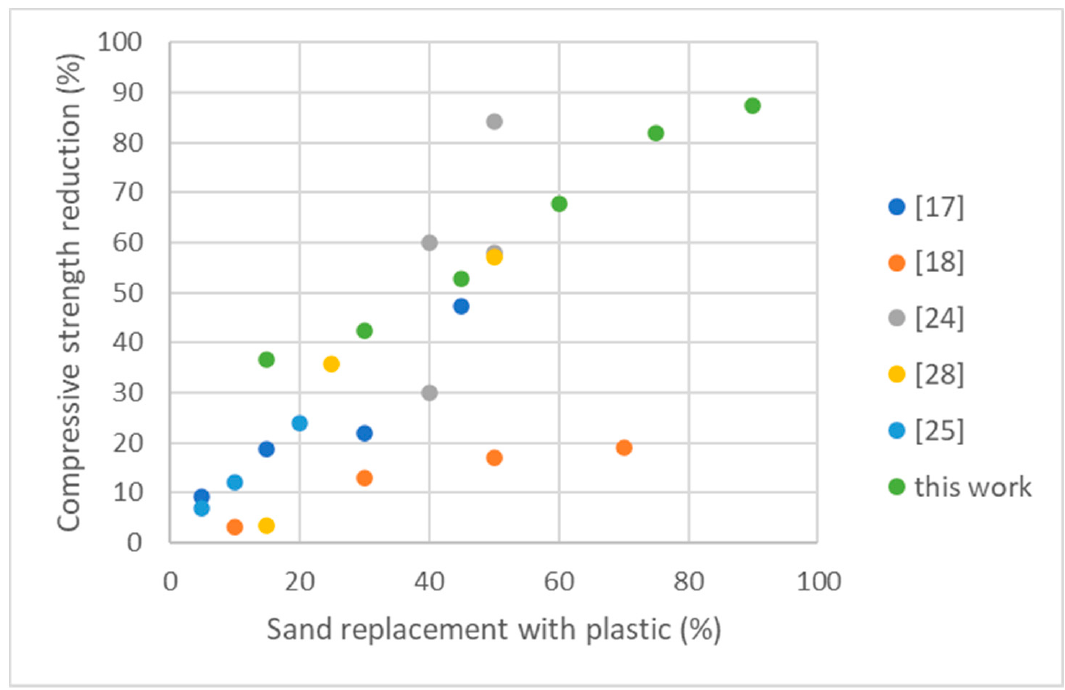
Figure 4. Comparison of compressive strength reduction with other literature work.